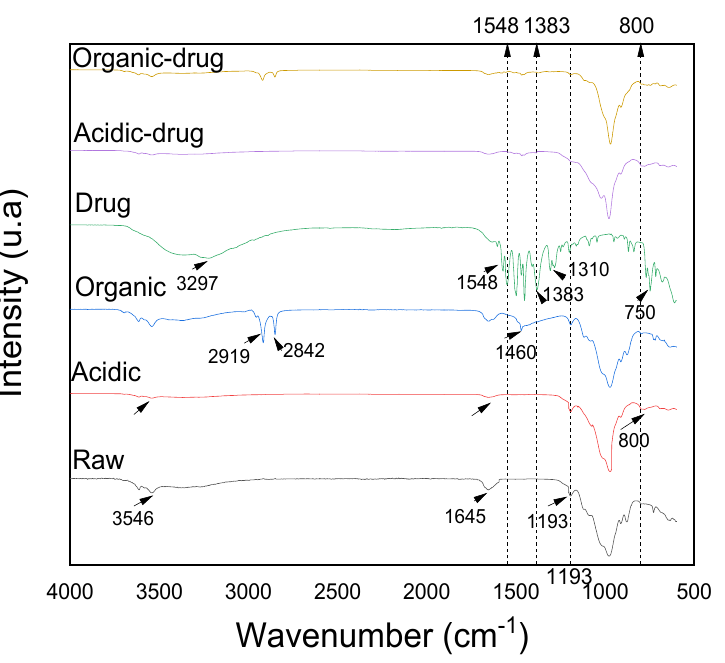
Figure 10. FTIR spectra of the raw and functionalized samples before and after the adsorption of the sodium diclofenac.